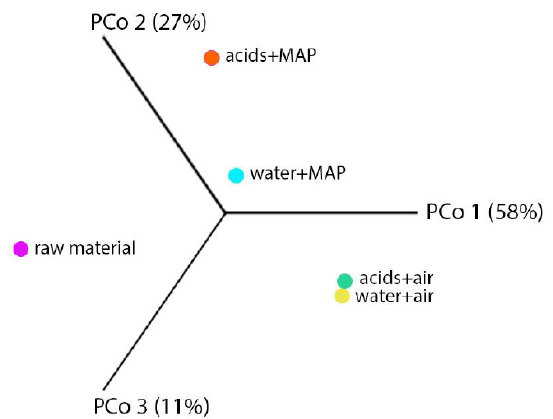
Figure 4. Principal coordinates analysis (PCoA) based on Bray–Curtis index for carrot microbiome stored under refrigerated conditions.